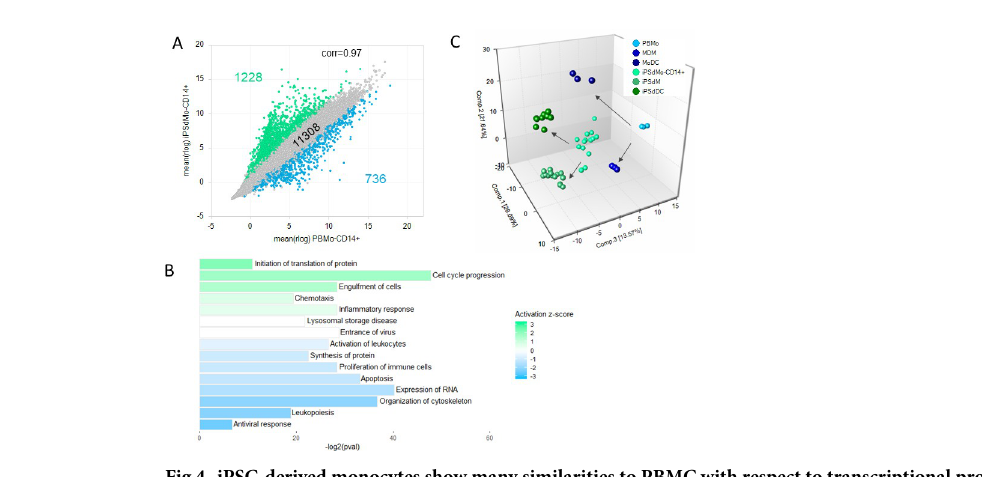
Fig 4. iPSC-derived monocytes show many similarities to PBMC with respect to transcriptional profile and differentiation capacity. (A) Correlation scatter plot of the average rlog expression values for PBMo versus iPSdMo. Only genes with TPM > 2 in either group are shown. Genes with fold change > 4 in green and genes with fold change < -4 in blue. (B) Summary of functional groups enriched for the 1964 DE genes. Bar length is the–log2 of the enrichment p-value and the colour represents the z-score with green indicating functions activated in iPSdMo relative to PBMo and blue bars those activated in PBMo relative to iPSdMo. (C) PCA plot of the various iPSdMo, iPSdM, iPSdDC, PBMo, MDM and MoDC samples. The arrows illustrate the progression of either PBMo or iPSdMo to either MDM/ MoDC or iPSdM/iPSdDc respectively.